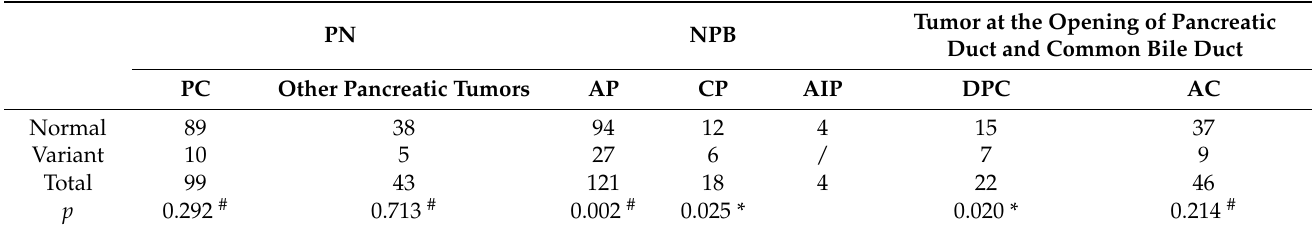
Figure 10. Type 2b. A 45-year-old female patient with Cholangitis. ( a ): MIP [45keV MEI(+)] shows MPD (long arrow) flows into MiP and extends to the tail of the pancreas. The tiny APD (short arrow) communicates with the front segment of the MPD without flowing into the MP. ( b ): MinIP [45keV MEI(+)] shows the overall configuration of the pancreatic duct and the thin duct in the tail. MPD refers to anatomically large and functionally dominant ducts. Table 2. Distribution of normal group and variant group in pancreas-related